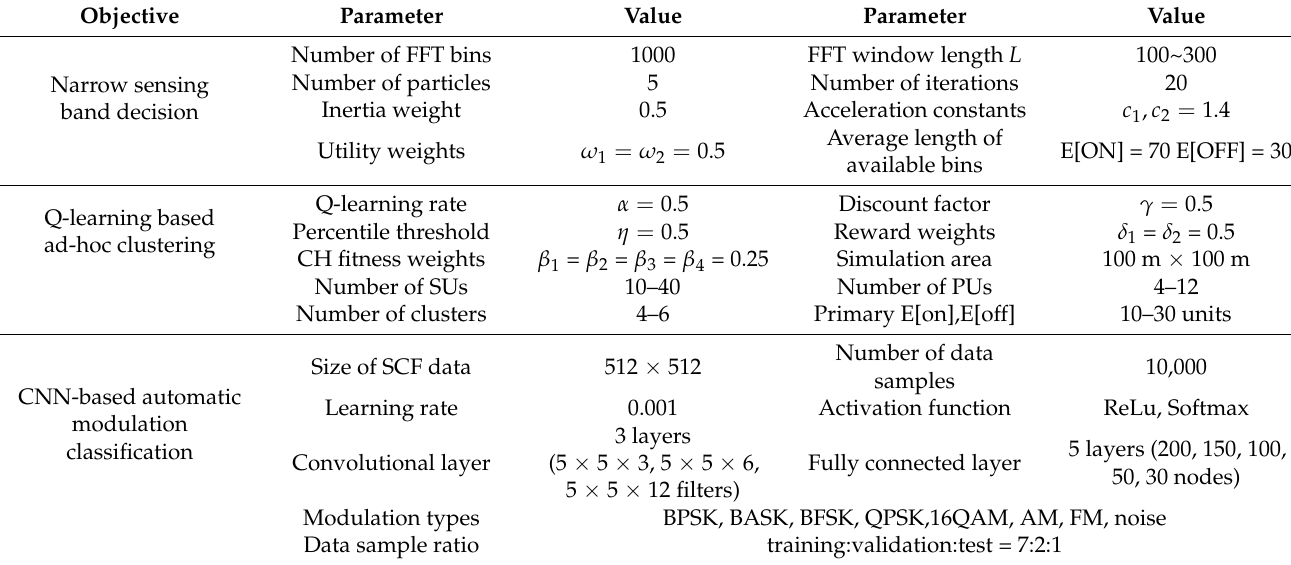
Table 2. Simulation